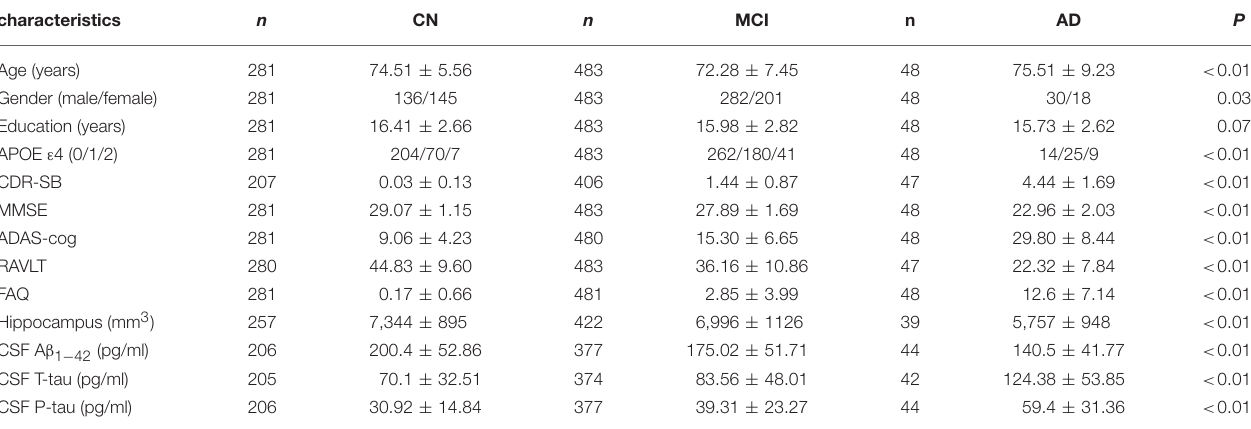
TABLE 1 | The characteristics of the ADNI subjects at